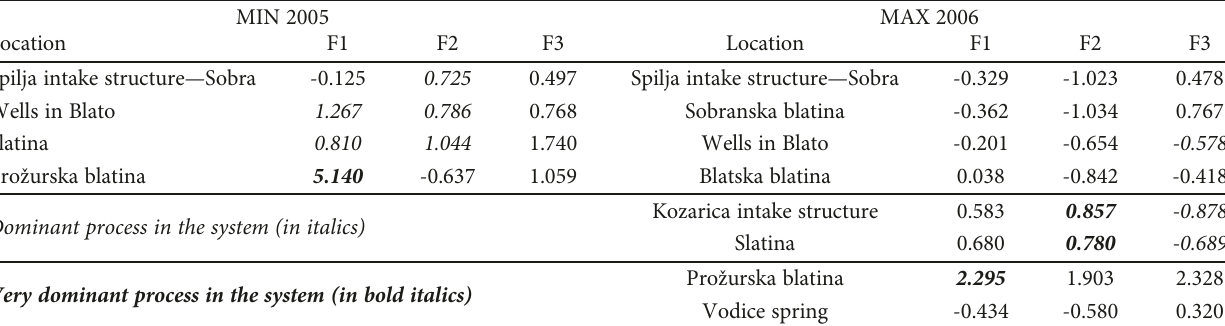
Table 3: Factor scores. Speci fi c objects are described by three dominant